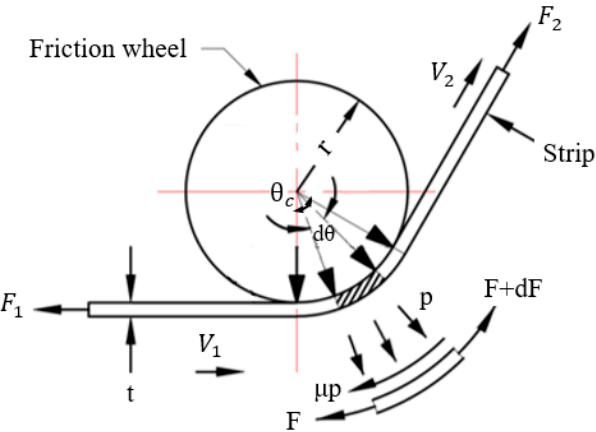
Figure 1. Free body diagram and geometric configurations between strip and friction wheel.